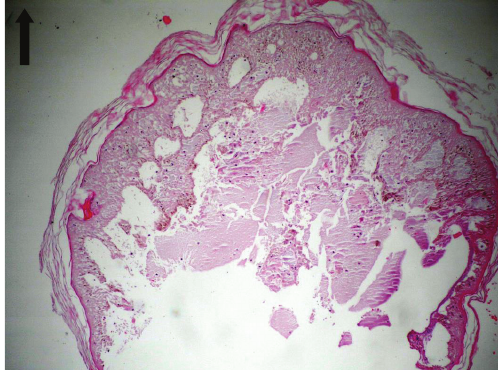
Figure 3: Development of subepidermal bullae and epidermal separation. HEX